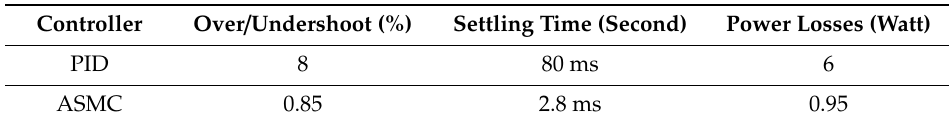
Table 4. Performance characteristics of the conventional controller and the proposed ASMC controller based on PSO 10 particles.